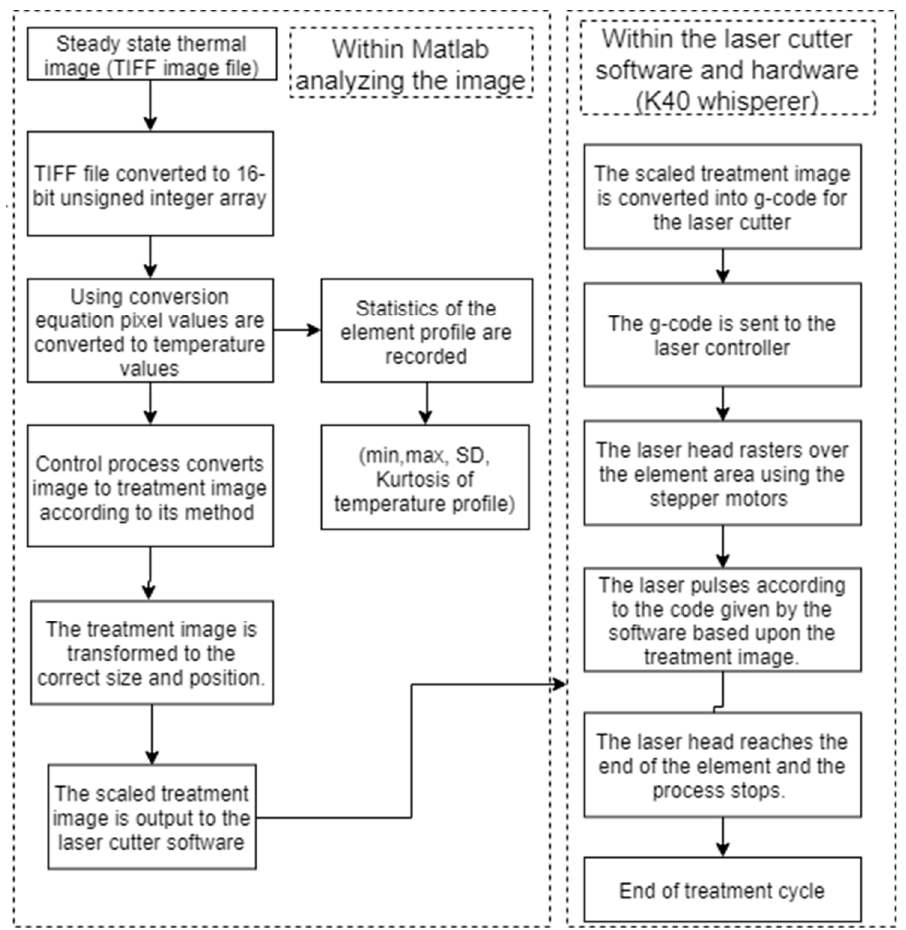
Figure 12. Processing control strategy employed by the Matlab software to transfer the infrared image data to a laser processing strategy.